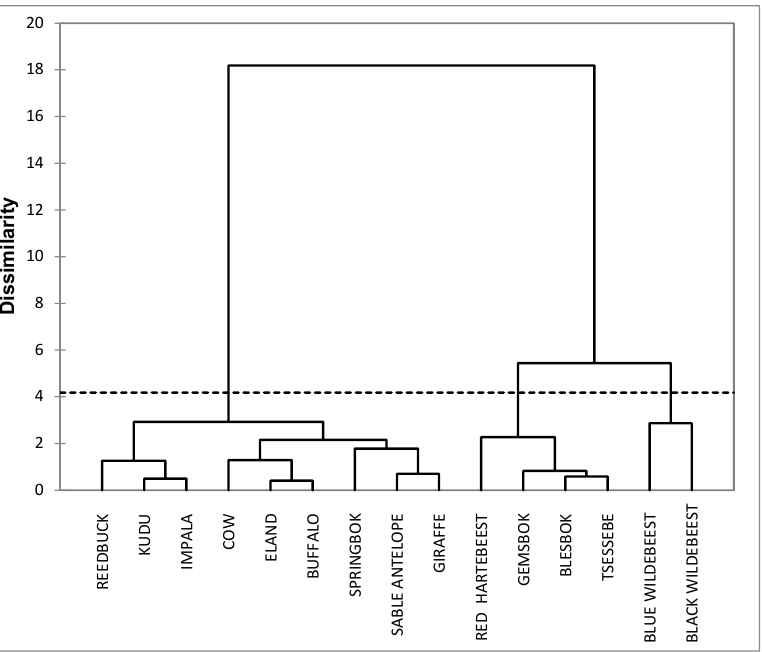
Figure 2. Dendrogram of 15 Ruminantia species with regard to milk content of protein, non-protein nitrogen, lactose, oligosaccharides, fat, and fatty acids.